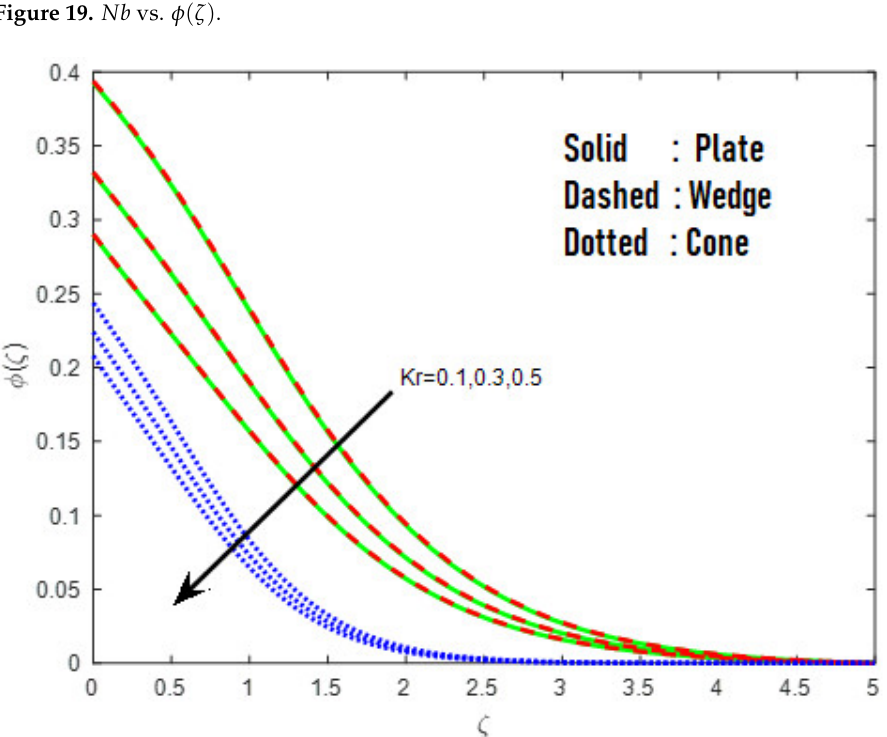
    . Figure 20. Kr vs. φ ( ζ )     .